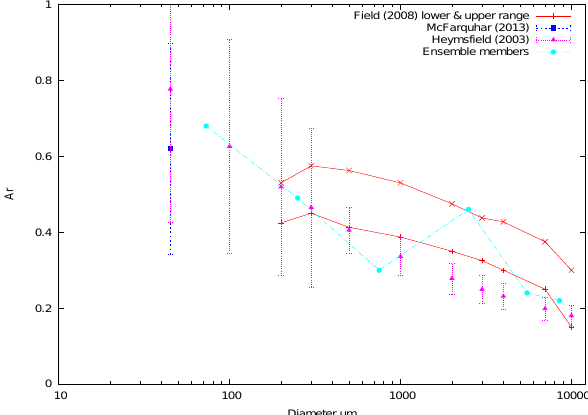
Figure 2. The ensemble model as a function of ice crystal maximum dimension, D max . The first element of the model is the hexagonal ice column of aspect ratio unity (first top left), followed by the 6- branched bullet rosette (top centre), the 3-monomer hexagonal ice aggregate (top right), 5-monomer ice aggregate (first bottom left), 8-monomer ice aggregate (bottom centre) and the 10-monomer ice aggregate (bottom right).